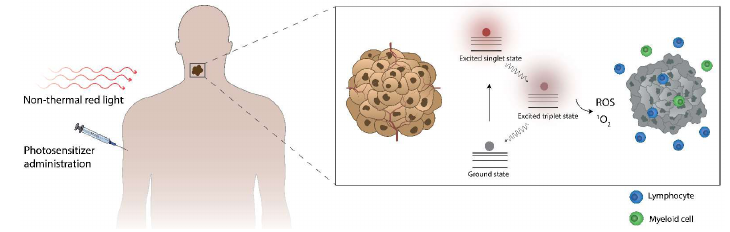
Figure 1. A short summary of photodynamic therapy.